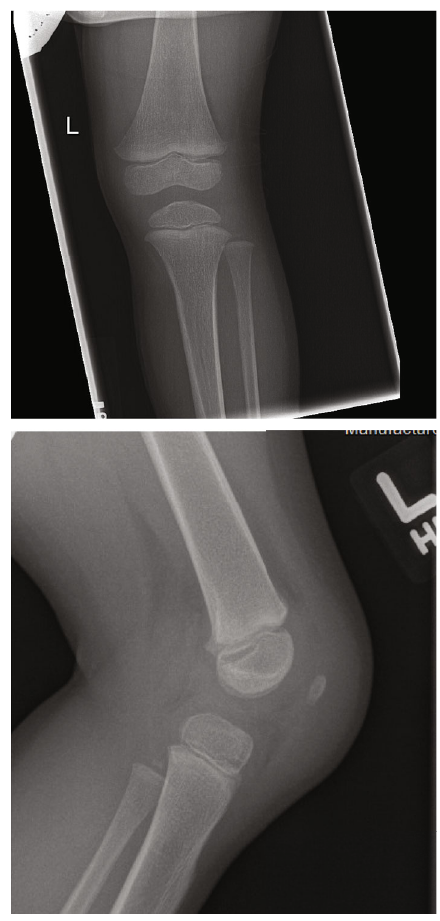
no obvious bony injury or e ff usion but notable prepatellar soft tissue swelling.